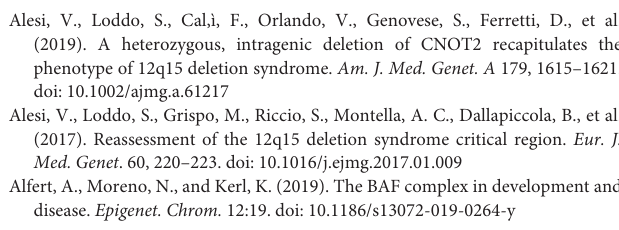
Supplementary Table 8 | Public data